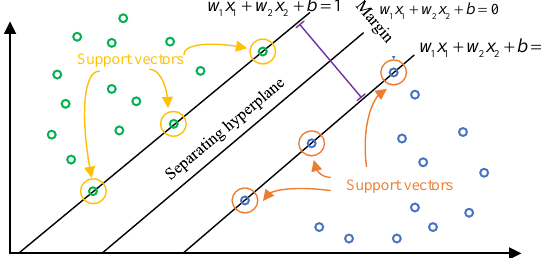
6 of 14 Figure 5. Principle of hybrid machine learning model. 3.2. Support Vector Machine